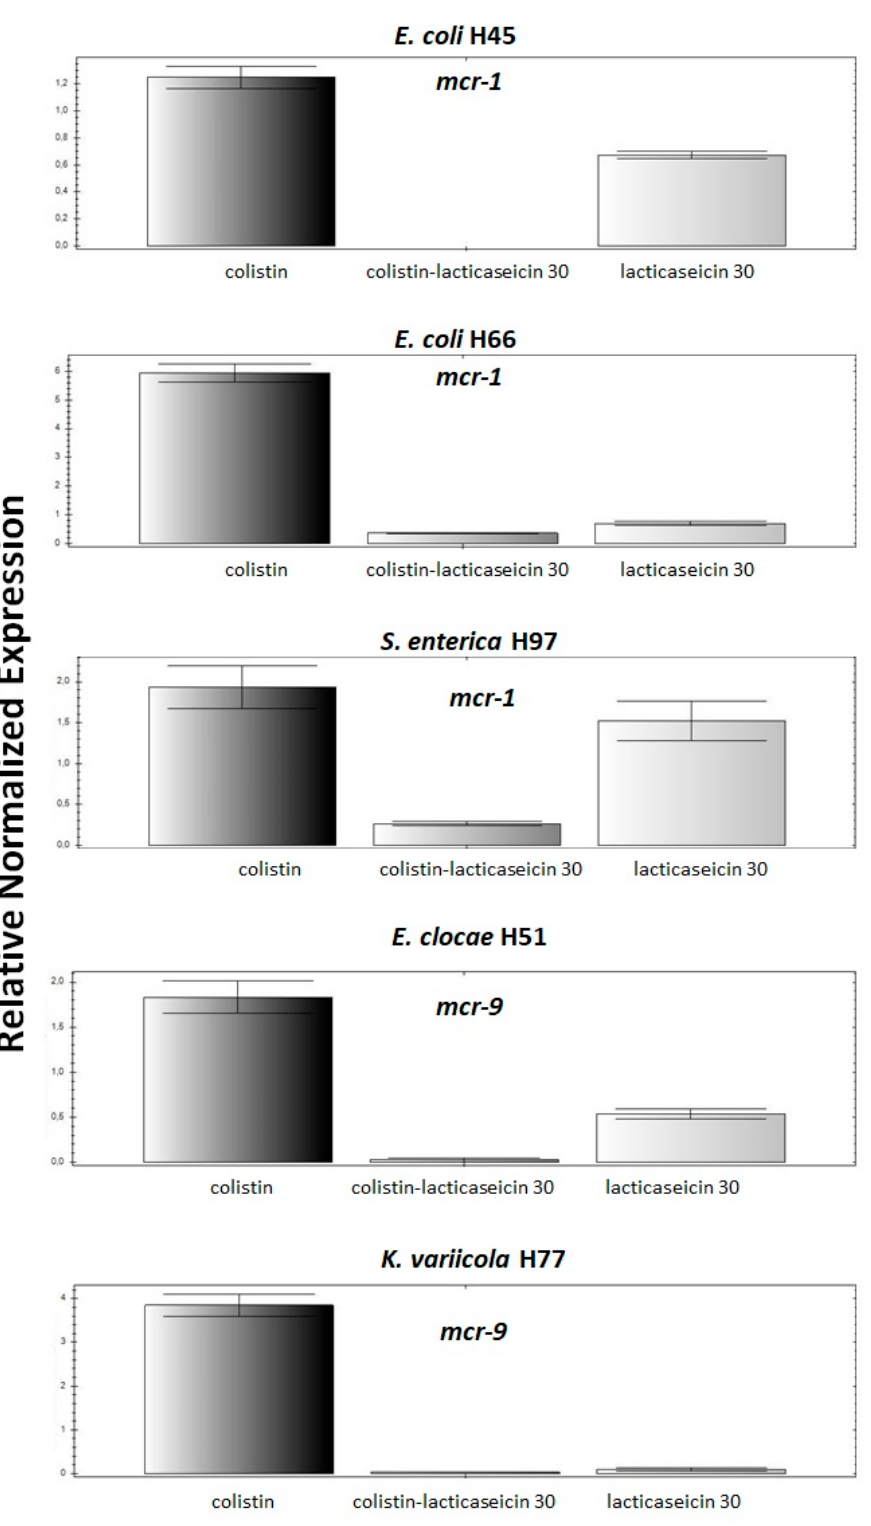
Figure 3. Expression of mcr-1 or mcr-9 gene ( mcr-1 or mcr-9 ) following bacterial treatment with colistin, lacticaseicin 30 or their combination at sub-inhibitory concentrations (MIC/2). qPCR assays performed in strains for which a synergetic interaction between lacticaseicin 30-colistin has been evidenced. Furthermore, the 16S rRNA gene was used as internal control as house-keeping gene. Three biological and technical replicates of each reaction were performed. The error bars represent a standard deviation of these replicates.